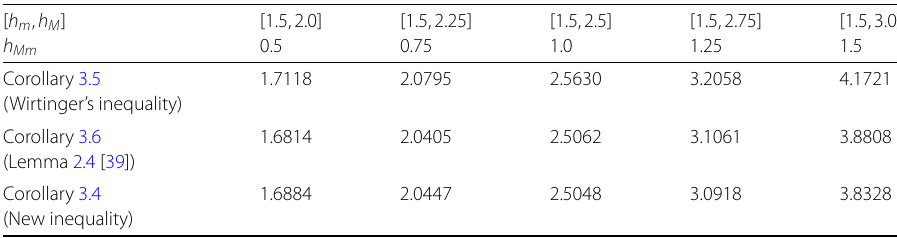
Table 6 MALBs of c 2 for T = 30, (cid:9) = 0.45 and different values of [ h m , h M ] in Example 4.2 (Case II)